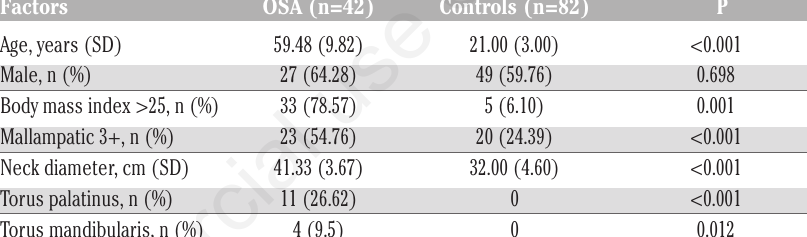
Table 1. Clinical features of obstructive sleep apnea patients and healthy control.